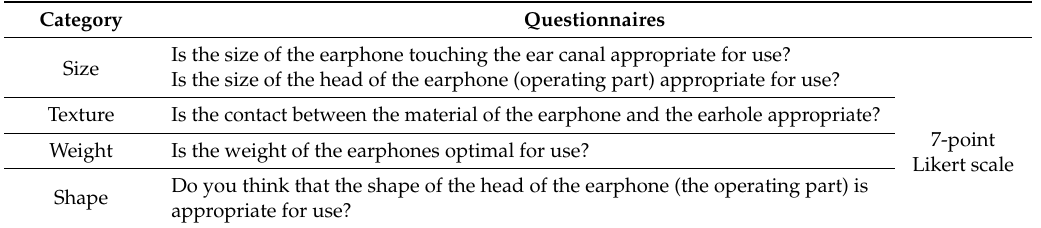
Table 4. Evaluation questionnaires for the appropriateness of the device design.